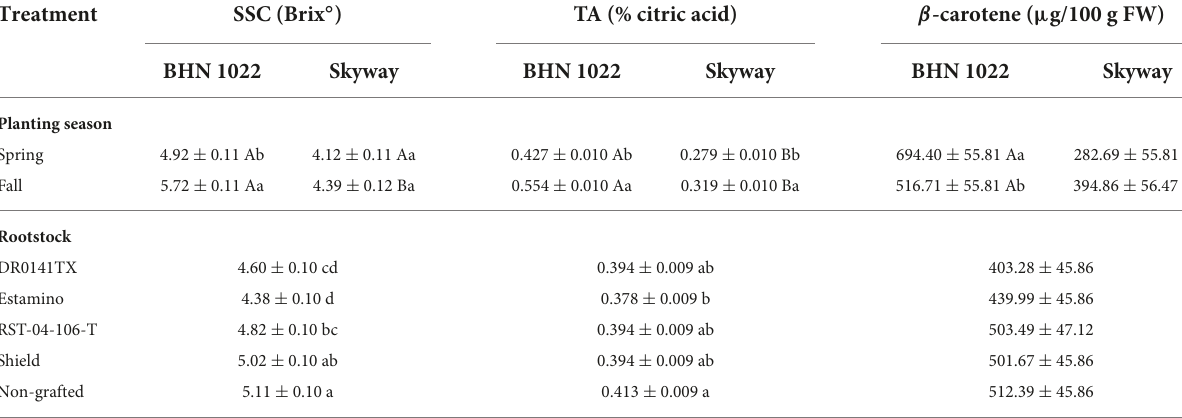
TABLE 7 Soluble solids content (SSC), titratable acidity (TA), and β -carotene content of fruit from grafted beefsteak tomato ‘Skyway’ and grape tomato ‘BHN 1022’ in Spring and Fall plantings. Treatment